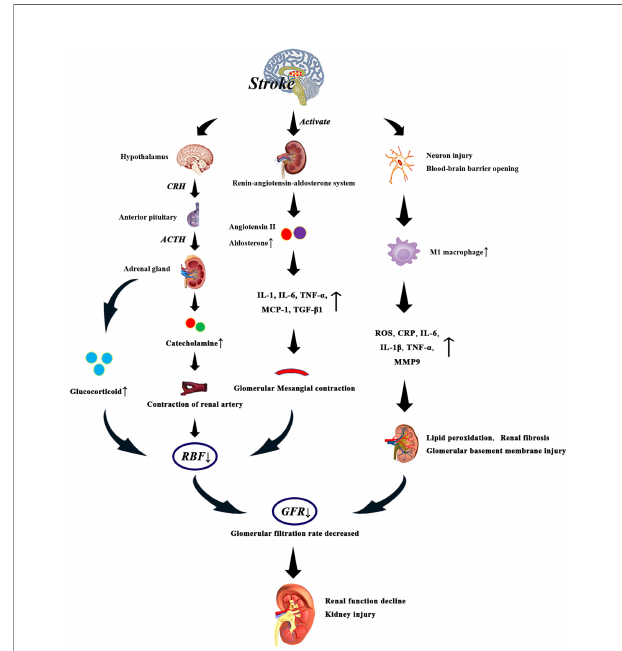
FIGURE 3 | After stroke, the levels of glucocorticoid, catecholamine, angiotensin II and aldosterone increased due to the activation of HPA axis and renin-angiotensin-aldosterone system. Especially when the level of glucocorticoid is too high, the renal blood fl ow decreases signi fi cantly, which leads to the decrease of glomerular fi ltration rate. Catecholamine and angiotensin II bind to renal artery receptors and promote renal artery contraction and renal ischemia. Activation of renin-angiotensin-aldosterone system can promote systemic and glomerular capillary hypertension, and the direct fi brogenic and pro-in fl ammatory effects of angiotensin II and aldosterone may also lead to renal injury. In addition, angiotensin II can increase the levels of IL-1, IL-6, tumor necrosis factor- a and monocyte chemoattractant protein-1, thus reducing glomerular blood fl ow. On the other hand, after stroke, neurons are damaged, the blood-brain barrier is destroyed, and the production of M1 macrophages is increased, which induces the production of in fl ammatory factors such as C-reactive protein, IL-6, IL-1 b , tumor necrosis factor and matrix metalloproteinase-9, which leads to renal injury. These events eventually lead to decreased glomerular fi ltration rate, decreased renal function, and irreversible kidney damage.